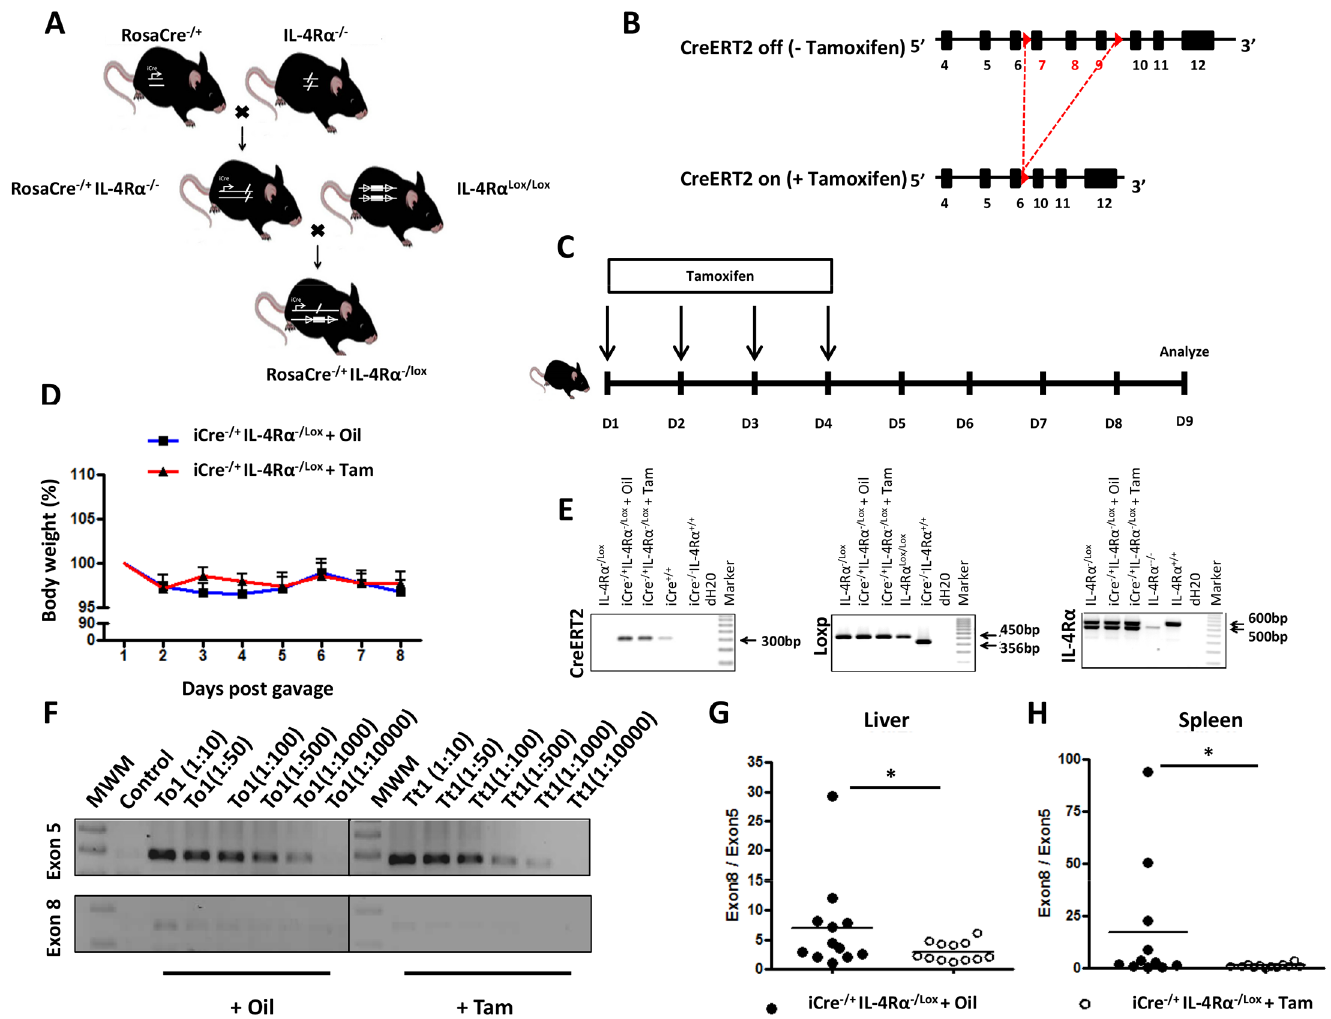
Fig 1. Generation and genotypic characterization of the RosaCre -/+ IL-4R α -/lox deletable mouse model. A. IL-4R α -/- C57BL/6mice were intercrossed with RosaCre expressingand IL-4R α Lox/Lox mice to generateRosaCre -/+ IL-4R α -/lox (i.e. iCre -/+ IL-4R α -/lox mice). B. Schematicof the expected il-4r gene loci in iCre -/+ IL-4R α -/lox mice fed or not with Tamoxifen. C. Experimental designfor assessingthe inducibledeletionof il-4r α in Tamoxifen-fed iCre -/+ IL-4R α -/lox mice. D. Short-term effect of Tamoxifen gavage on body weight. E. Genotypingof iCre -/+ IL-4R α -/lox mice. The creer T2 specific ampliconis 300bp, loxp is 450bp.In wild type mice, the il-4r α ampliconis 600bpand 471bp in mice with a deleted il-4r α gene. F. Semi-quantitative PCR analysesof Exon 8 (only deletedin mice with an activated CreER T2 ) vs. Exon 5 (present in all mice) betweeniCre -/+ IL-4R α -/lox mice fed either with oil or Tamoxifen.( G, H). Quantitative real-time PCR of exon 8 over exon 5 from the il-4r α gene. Genomic DNA was extracted from liver tissue ( G ) or splenocytes ( H ) and exon 8 from il-4r α was quantified by qPCR and normalized to exon 5. Each experiment was conductedat least twice with 3–4 mice per group. Data are expressedas mean ± SD; NS = p > 0.05; * = p < 0.05; ** = p < 0.01; *** =, p < 0.001; **** = p < 0.0001.